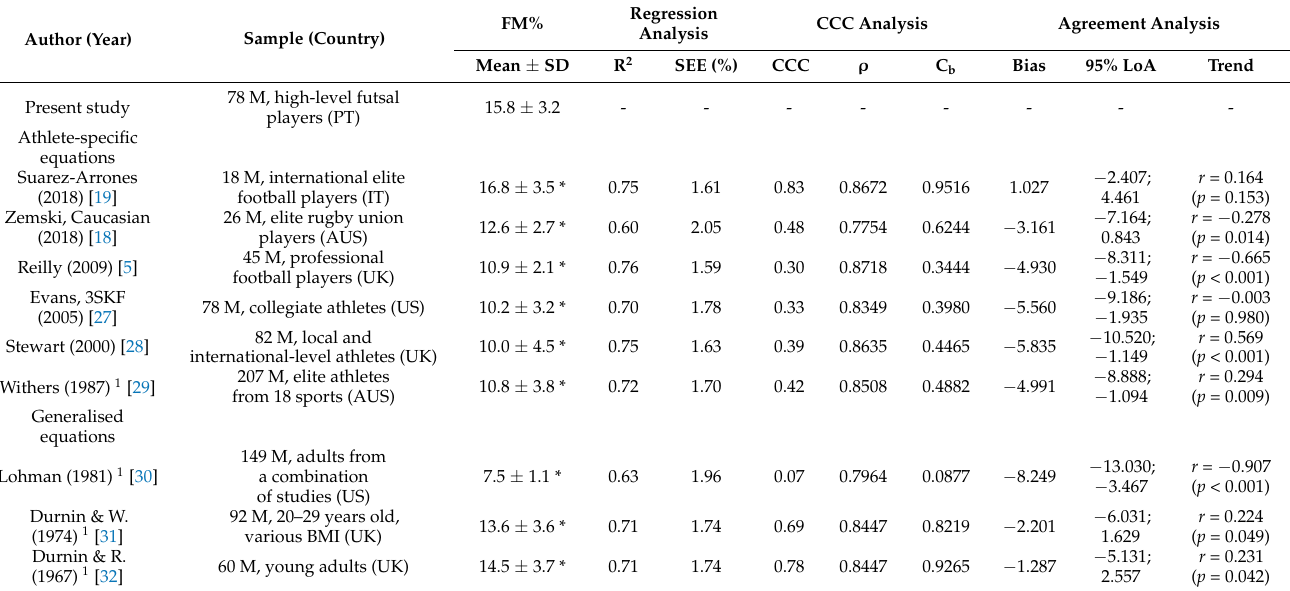
Table 2. Cross-validation of existing anthropometric equations for fat mass percentage